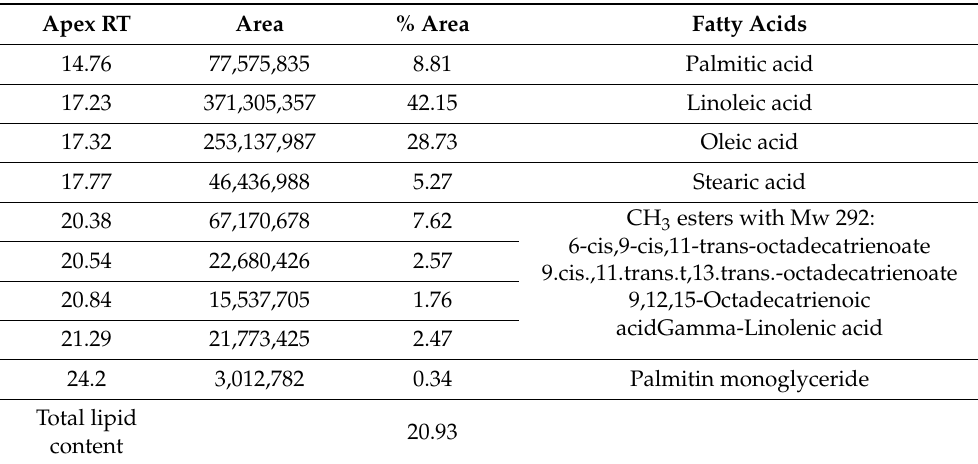
Table 3. Total lipid content and fatty acids composition of AyuFertin.